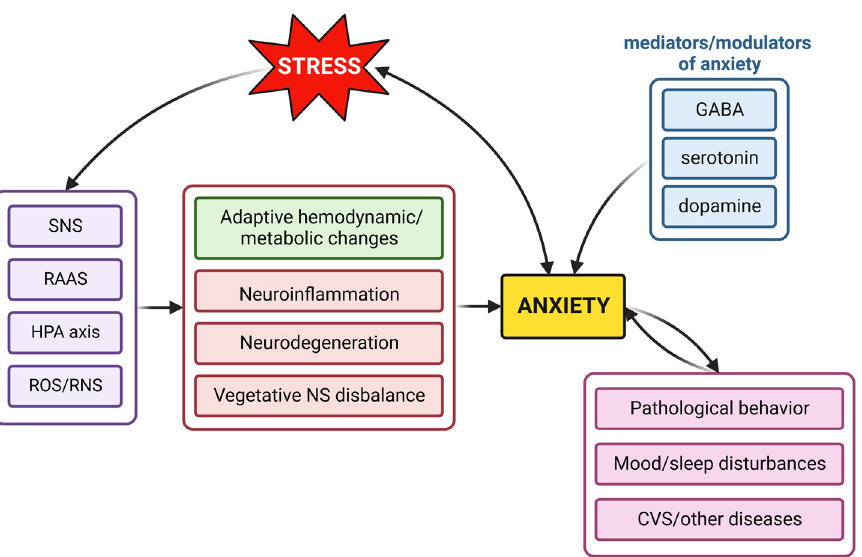
Figure 1. Proposed mechanisms of anxiety development. During the stress reaction, neurohumoral systems including the sympathetic nervous system (SNS), renin–angiotensin–aldosterone system (RAAS) and hypothalamus–pituitary–adrenal (HPA) axis are activated, and free radical formation is enhanced. As a result, aside from adaptive hemodynamic and metabolic changes, inflammatory and degenerative alterations and the disbalance of the vegetative nervous system (NS) occur. The result is the development of anxiety, which, in turn, potentiates or modifies the stress reaction. Established anxiety results in pathological behavior, mood and sleep disturbances and potentially in cardiovascular (CVS) and other systems’ disorders, while each of them or together may further promote anxiety. GABA, γ -aminobutyric acid; ROS, reactive oxygen species; RNS, reactive nitrogen